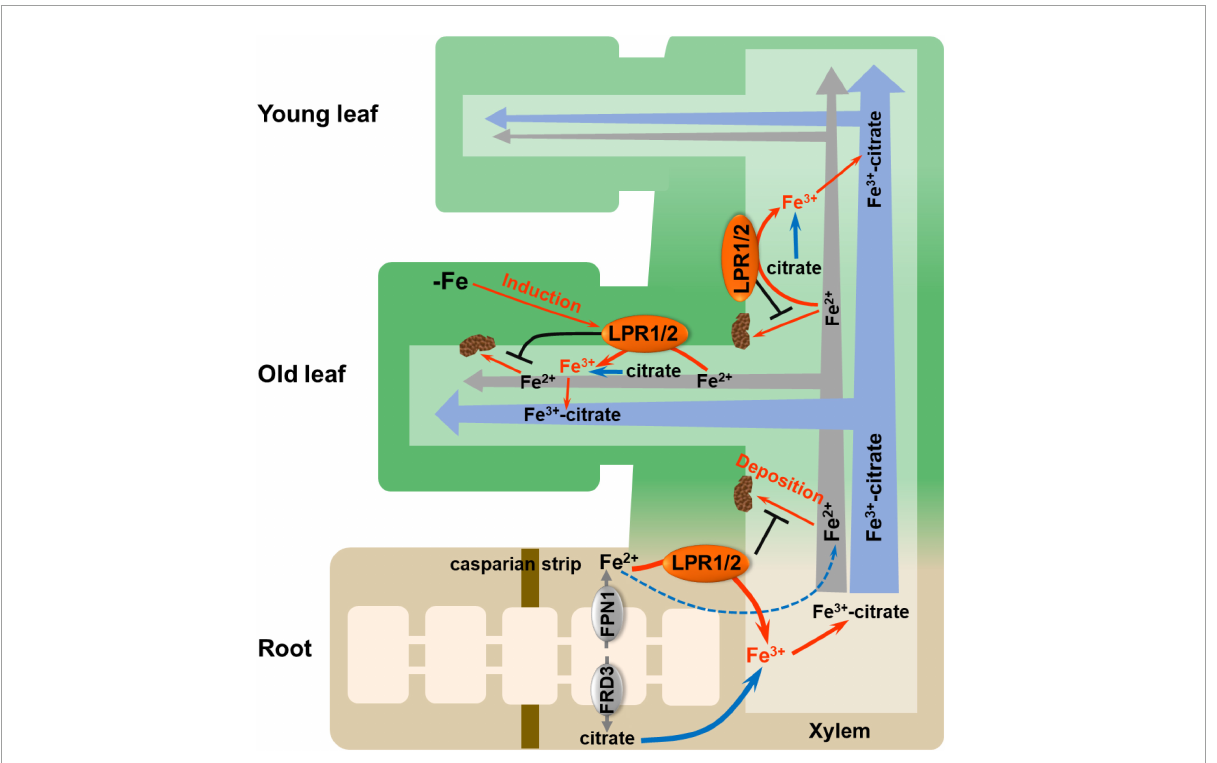
FIGURE8 Proposed model for LPRs-mediated Fe(II) oxidation in affecting Fe behavior in xylem. The vascular-located LPRs oxidize Fe(II) to Fe(III) in the cell wall matrix, which facilitates the formation of stable Fe(III)–citrate complex. This process prevents Fe(II) from being bound by the cell wall of xylem. In addition, low-Fe conditions preferentially induced the expression of LPRs in the old leaves, which avoids Fe deposition in the xylem cell wall of old leaves and thus favors the allocation of more Fe to younger leaves. LPR1/2 LPR1 and/or LPR2.